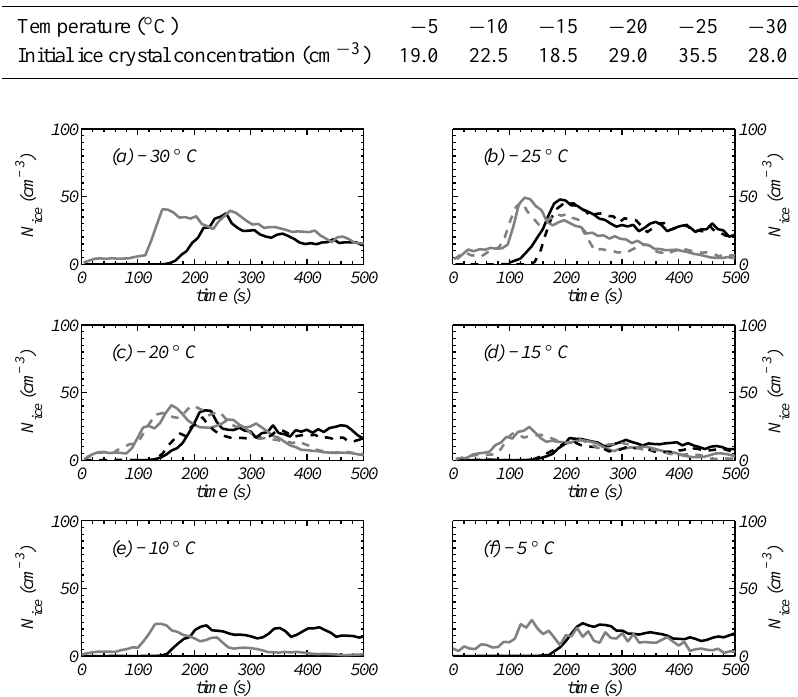
Table 1. Number concentrations of ice crystals nucleated at the top of the chamber by the “pop seed” and used as input to the model simulations.